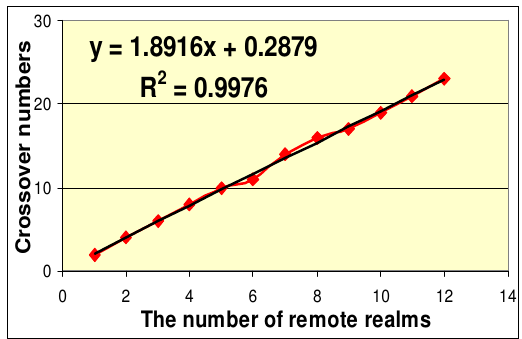
Figure 7. Crossover Numbers vs. The Number of Remote Realms numbers with varying number of remote realms. The crossover numbers can be 99.8% perfectly fitted by the straight line: n = 1 . 8916 m + 0 . 2879. This means